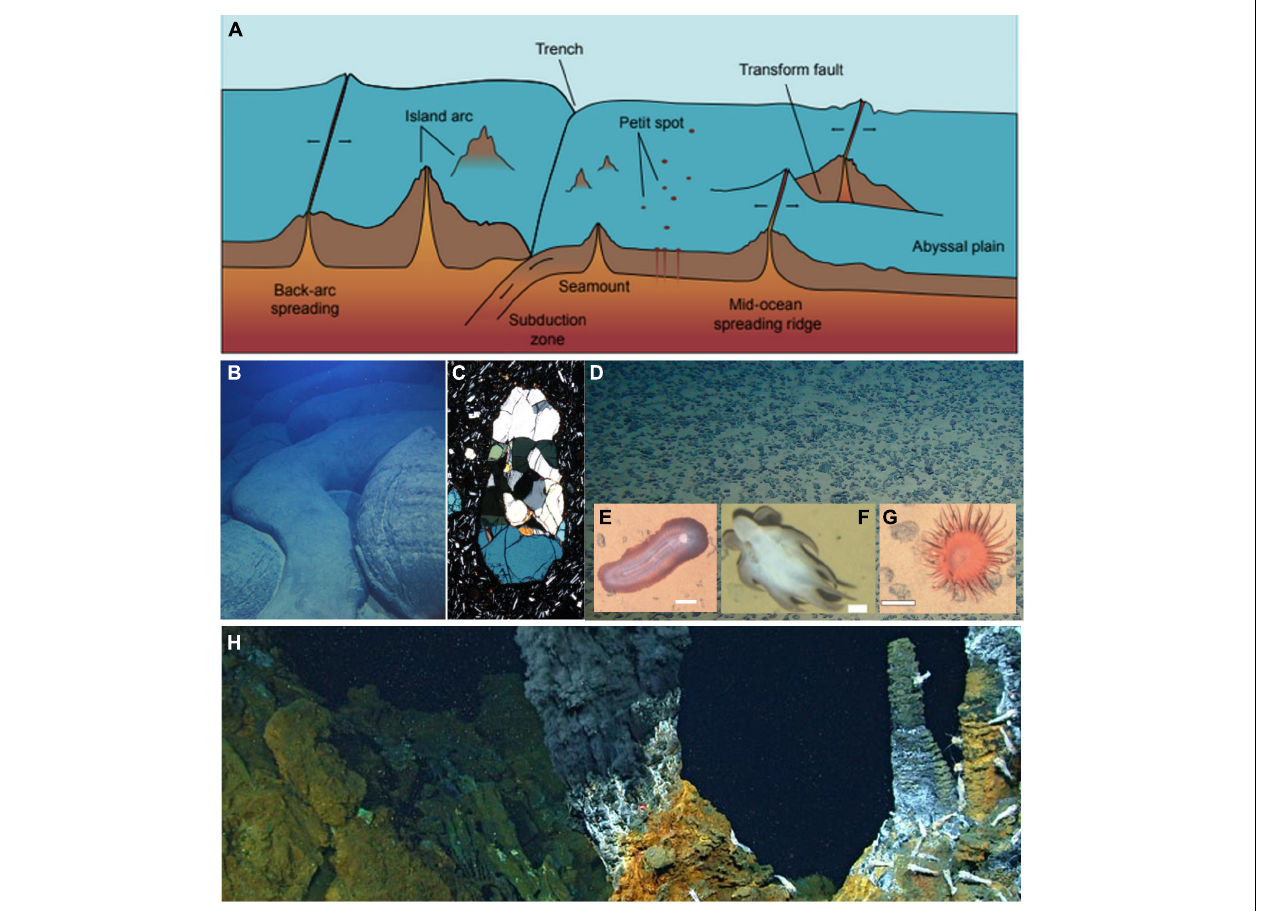
FIGURE 1 | Abyssal seafloor features in the context of open ocean environments. (A) A schematic outline of the diverse habitats and features on the abyssal seafloor, some of which extend above and/or below the abyssal zone. (B) Pillow basalt at a Petit Spot seafloor volcano, providing a window into the earth’s upper mantle through (C) peridotite xenoliths (image 2 mm across). (D) Abyssal seafloor nodules at the Clarion-Clipperton zone; insets show (E) Benthodytes, (F) Grimpoteuthis, and (G) Actiniaria; all scale bars 5 cm. (H) Hydrothermal chimneys with vent shrimp at the Piccard hydrothermal field. [Image credits: (B) Tohoku University; (C) Morishita et al. (2020); (D) GEOMAR; (E) Simon-Lledó et al. (2019); (F) Simon-Lledó et al. (2020); (G) Simon-Lledó et al. (2019); (H) Chris German,